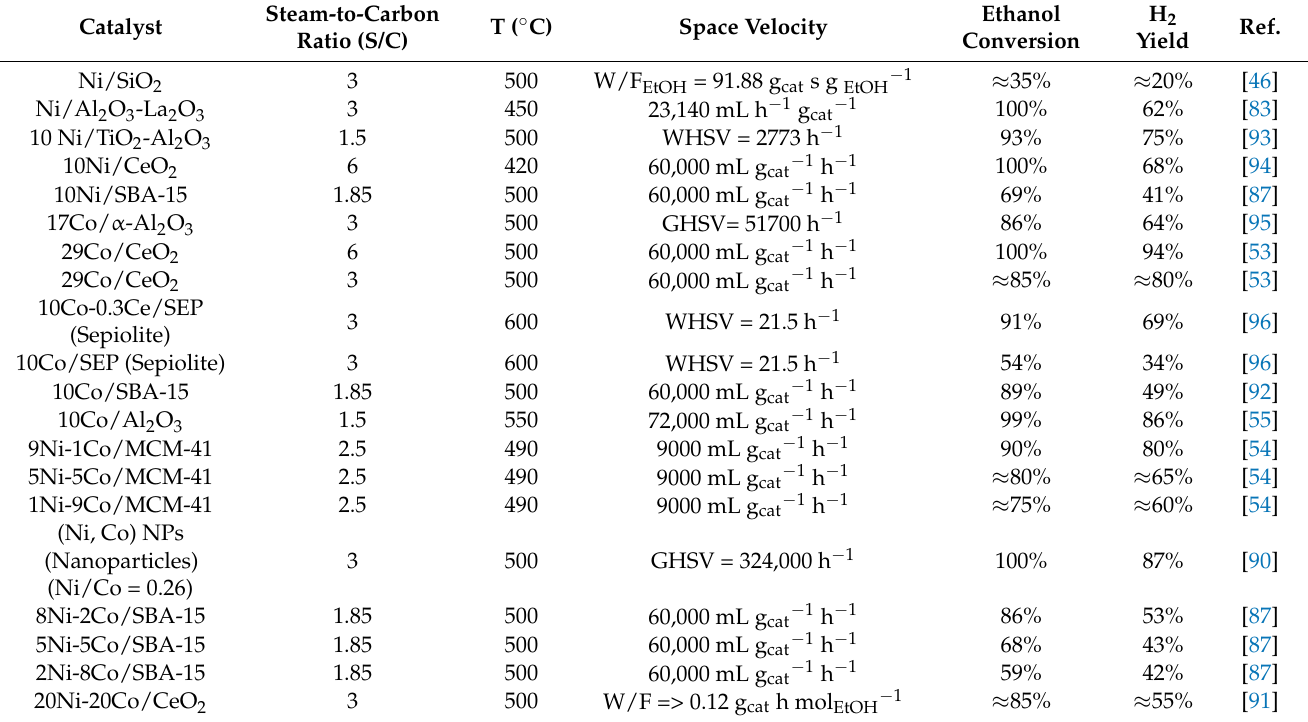
Table 1. Recent ESR studies on nickel, cobalt and bimetallic Ni-Co catalysts: operating condition, EtOH conversion and hydrogen